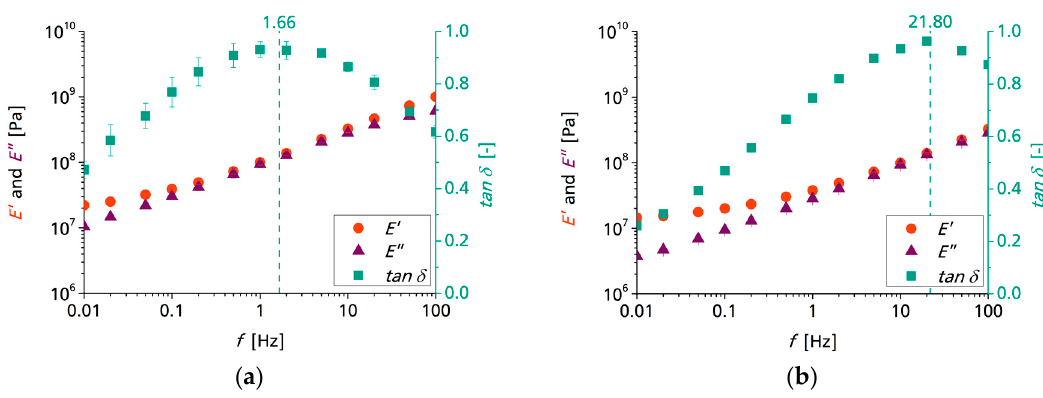
Figure 5. ( a ) Temperature sweep (1 Hz) of butyl rubber from − 100 to − 20 °C. ( b ) Frequency sweep of butyl rubber, T = − 50 °C. Storage modulus E ′ , loss modulus E ″ and loss factor tan δ are plotted against temperature ( a ) and frequency ( b ).